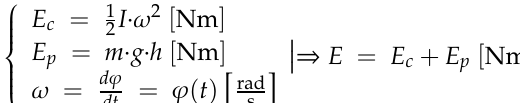
Figure 24. Schematic representation of the three-wire pendulum.